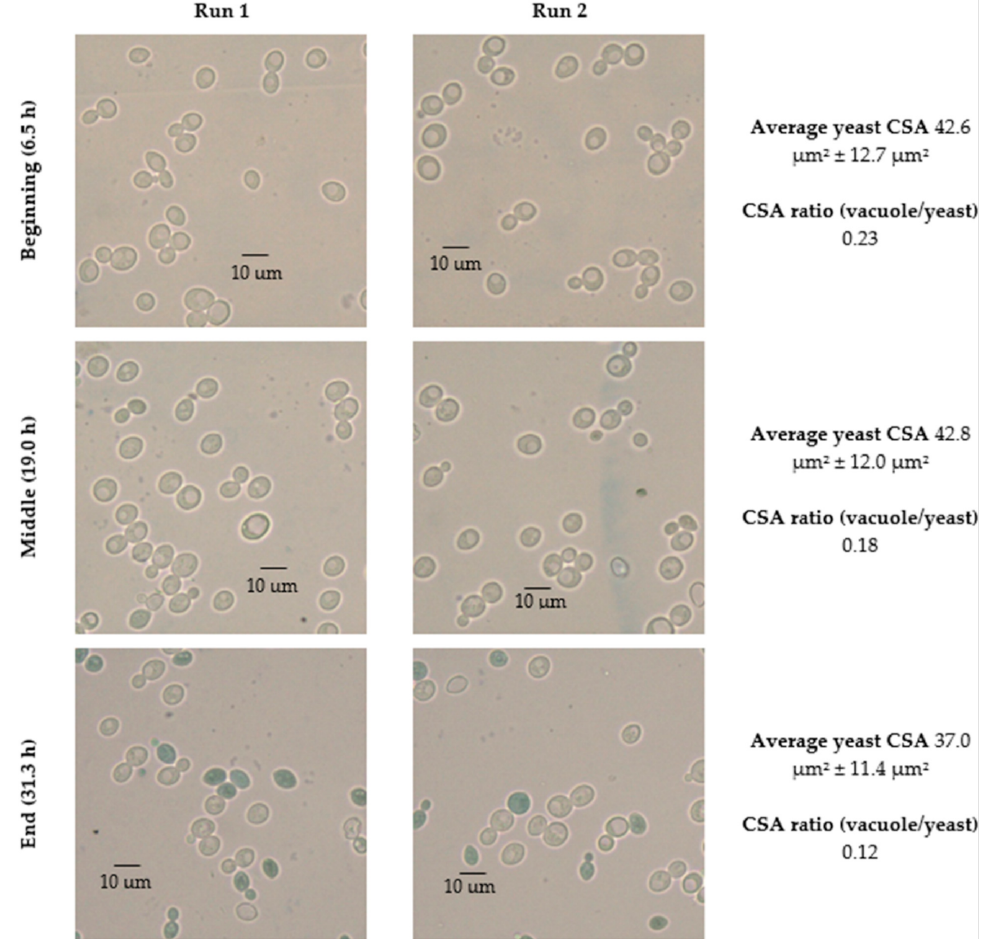
Figure 6. Bright-field microscopic image of yeast cells (1000 × magnification) of the duplicate runs from beginning, middle and end of the fermentation processes at 35 ◦ C. The media included 0.01% w/v methylene blue solution to differentiate non-viable cells from the analysis. The yeast CSA and CSA ratio (vacuole to yeast area) were determined manually using the Nikon